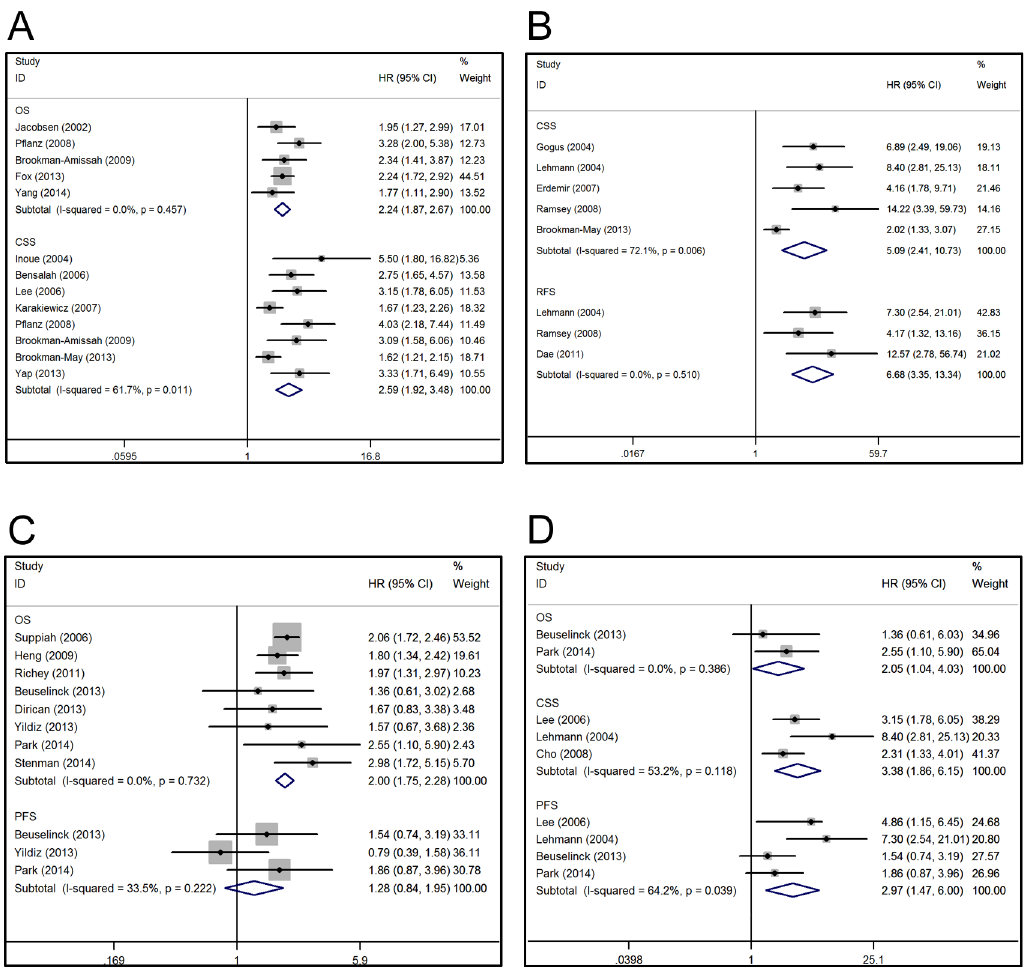
Fig 2. Forest plots of studies evaluating hazard ratios of elevated PC level compared with normal level. (A) Elevated PC level was associated with shorter overall survival and cancer-specific survival in renal cell carcinoma (All-stage group); (B) Elevated PC level was associated with poorer cancer- specific survival and recurrence-free survival in localized RCC (Localized group); (C) For metastatic RCC, elevated PC level was associated with worse overall survival but not progression-free survival (metastatic group); (D) For clear cell RCC, elevated PC level was associated with poorer overall survival, cancer-specific survival and progression-free survival.